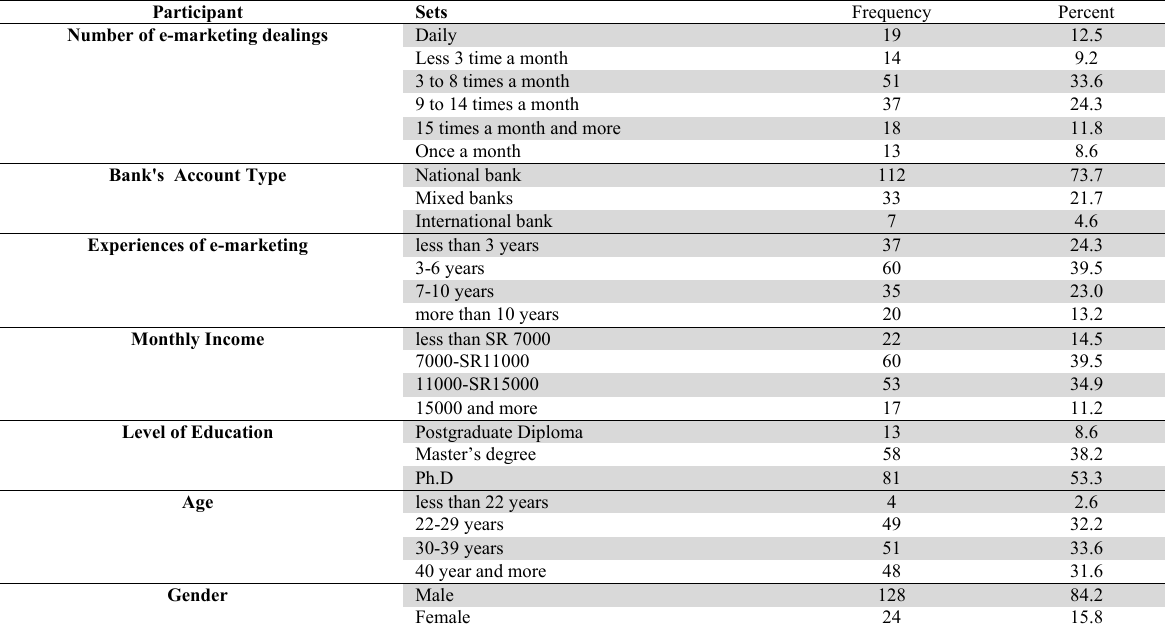
Participants' demographic characteristics (N=